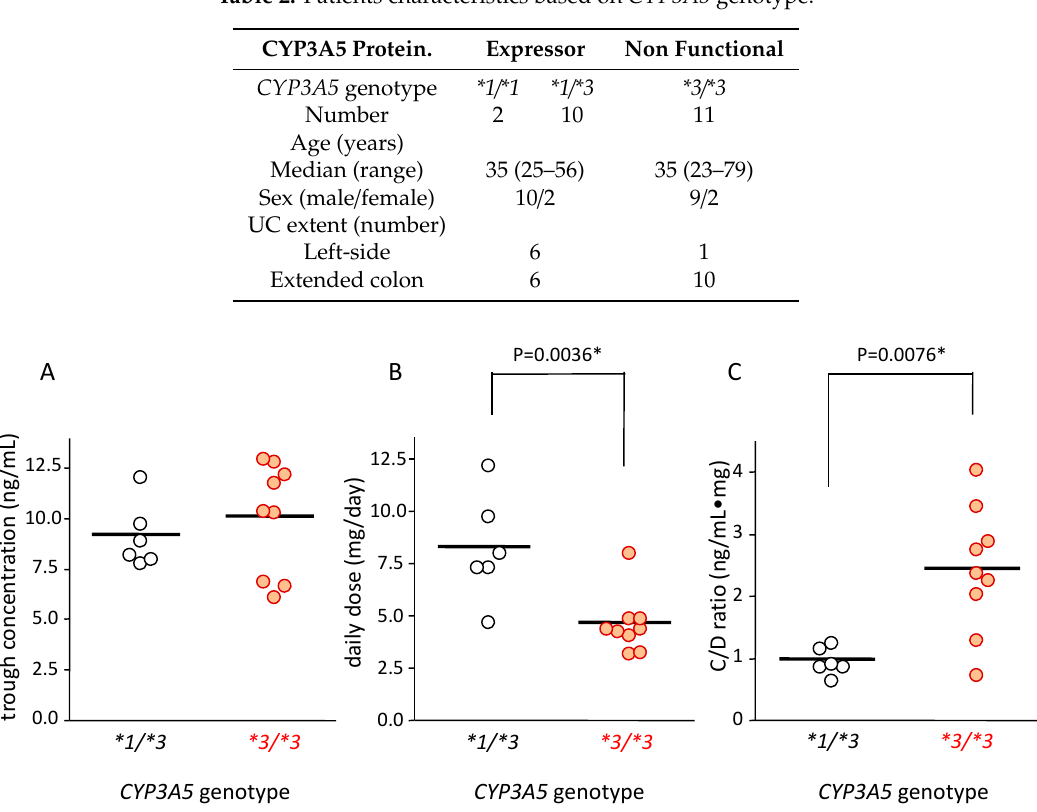
Figure 2. Relationship between CYP3A5 genotype and blood concentration ( A ), dose ( B ), and concentration / dose (C / D) ratio ( C ) of tacrolimus. The bar shows the mean in each group ( A , B ) and the median for the C / D ratio of tacrolimus. ( A ) The average concentration of tacrolimus trough level in each patient was plotted. The mean trough concentration in patients carrying CYP3A5*1 / *3 (n = 6) was similar to that of patients carrying CYP3A5*3 / *3 (n = 9). ( B ) The average dose of tacrolimus in each patient was plotted. The mean value of average dose of tacrolimus in patients carrying CYP3A5*1 / *3 was higher than that with CYP3A5*3 / *3 ( p = 0.0036 using Student’s t -test). ( C ) The average concentration / dose ratio of tacrolimus was plotted for each patient. Each point represents an average of 10 points. Bar shows the median value of all plotted points. Statistical analysis was performed using the Mann–Whitney’s U-test.